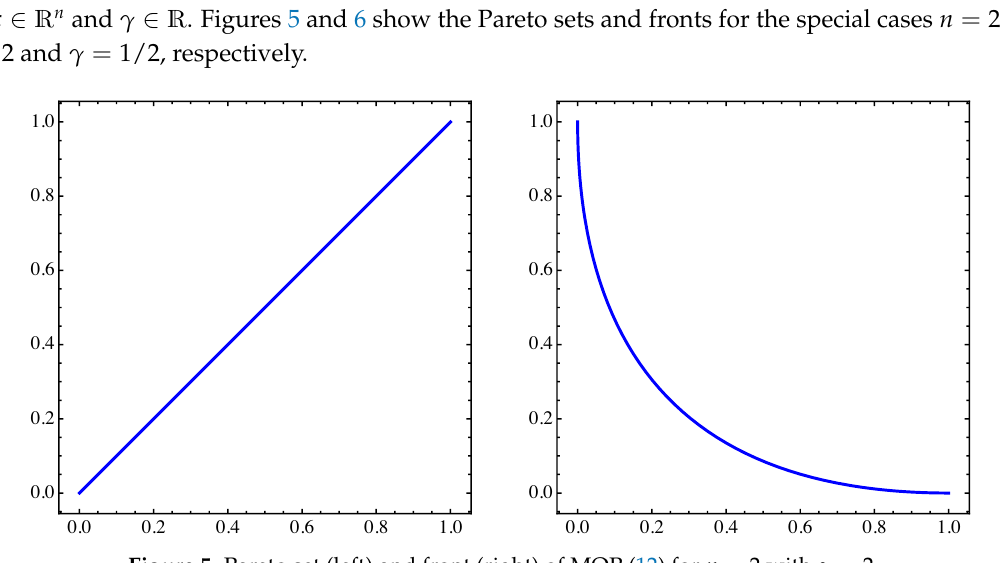
Figure 5. Pareto set (left) and front (right) of MOP (12) for n = 2 with γ = 2.